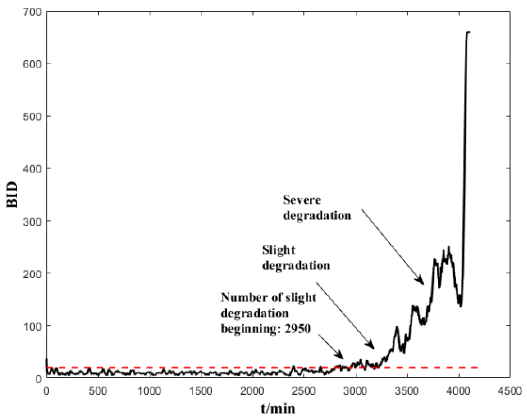
Figure 7. Performance assessment (BID) on the whole life time of B1.